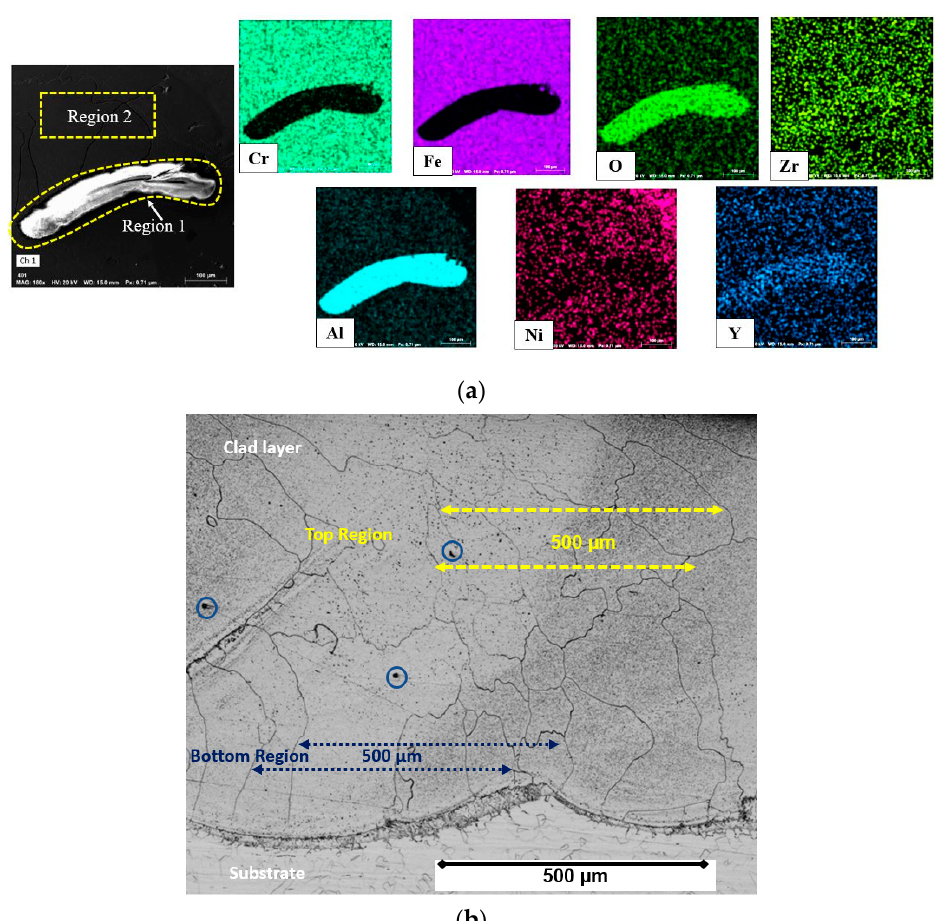
Figure 13. Cross-section analysis of the clad layer: ( a ) EDS mapping of slag, ( b ) microstructure. The microstructure of the clad layer is presented in Figure 13b. The presence of elongated and spherical pores discussed previously can be seen with the ~15 µ m